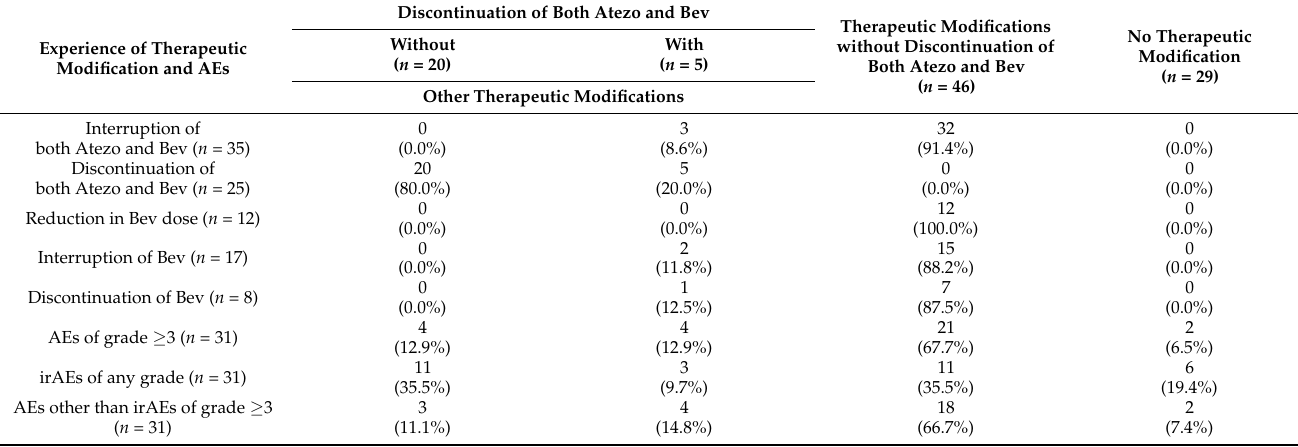
Table 4. Relationships between therapeutic modifications ( n =